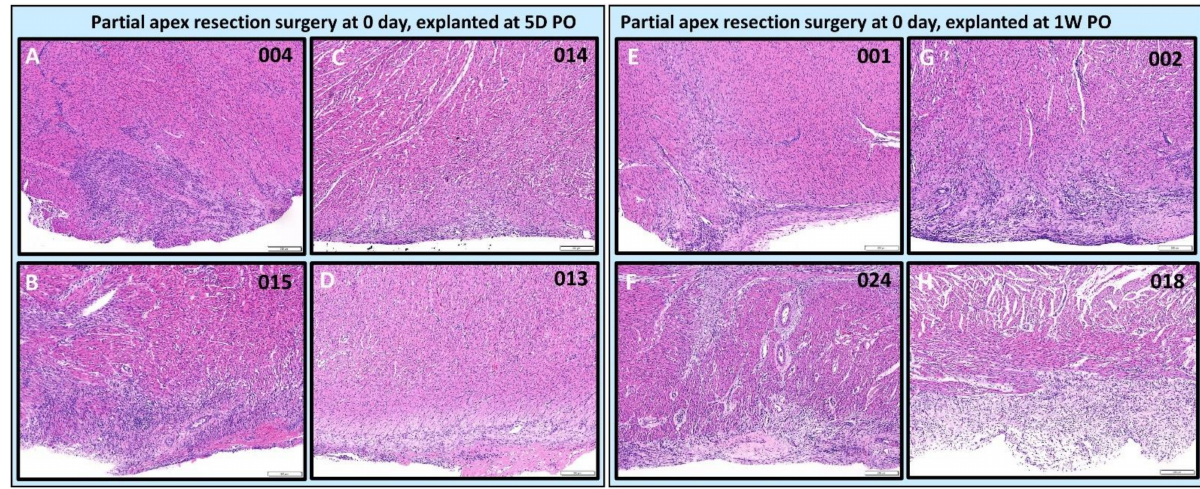
Figure 11. Partial apex resection surgery at 0 day and heart explants at 5D PO and 1W PO- Hematoxylin and Eosin (H & E) histology of 0-day surgery heart explants obtained five days post- operation (5D PO): ( A ) Zero-day surgery heart from piglet #004. ( B ) Zero-day surgery heart from piglet #015. ( C ) Zero-day surgery heart from piglet #014. ( D ) Zero-day surgery heart from piglet #013. H & E histology of 0-day surgery heart explants obtained one-week post-operation (1W PO): ( E ) Zero-day surgery heart from piglet #001. ( F ) Zero-day surgery heart from piglet #024. ( G ) Zero-day surgery heart from piglet #002. ( H ) Zero-day surgery heart from piglet #018. Histological images were taken at 4 × magnification (Scale bar = 200 µ m). H & E: pink–cytoplasm; blue–nuclei; intense